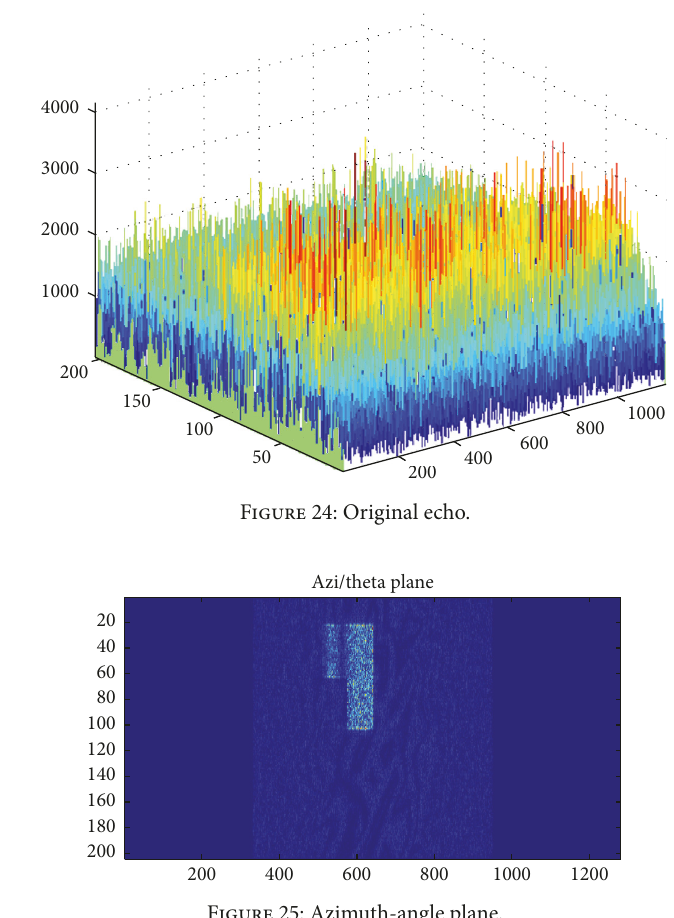
Figure 25: Azimuth-angle plane.